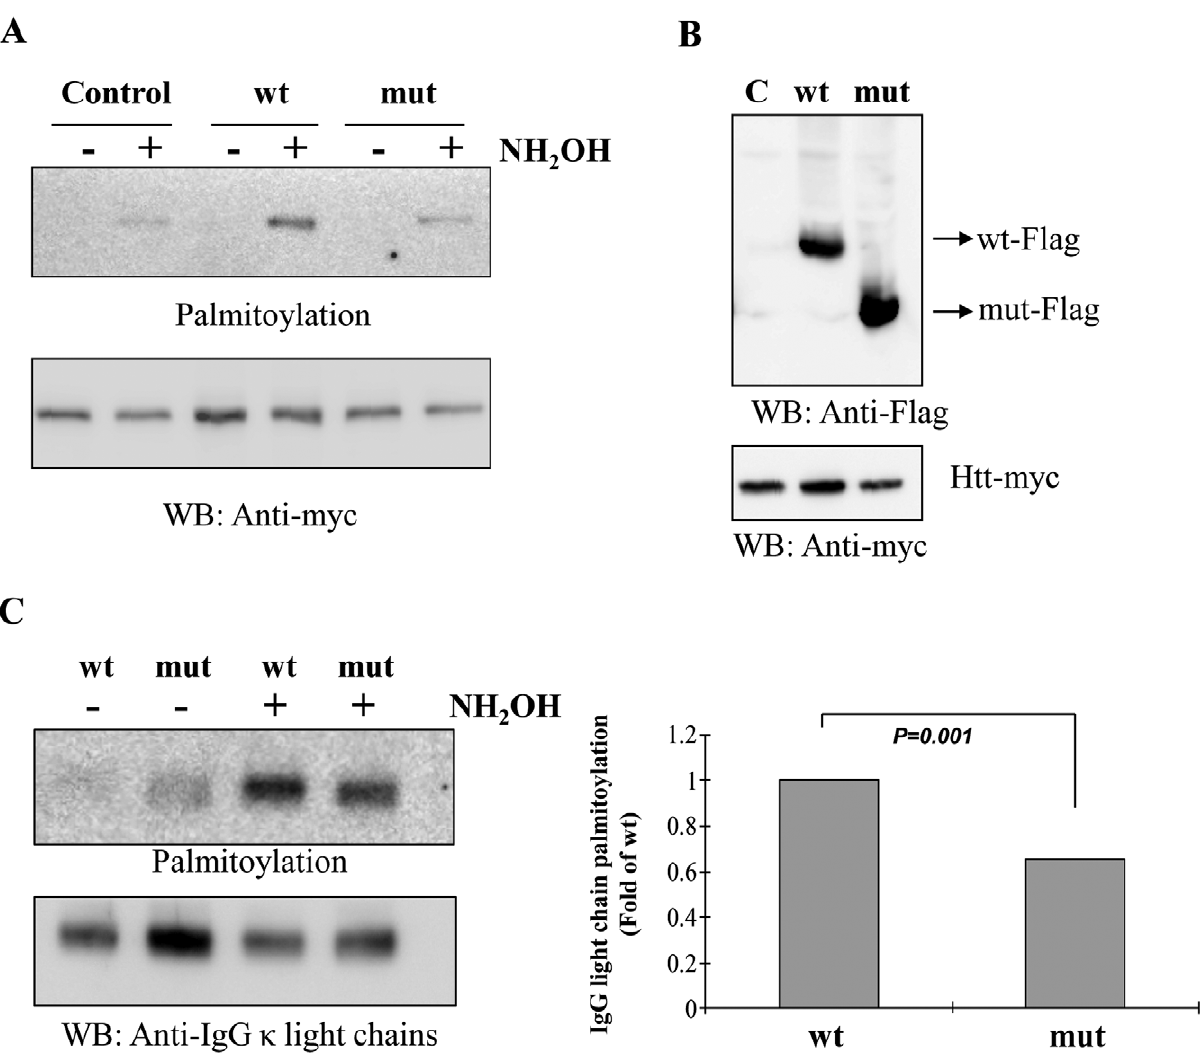
Figure 10. Palmitoyl-acyl transferase (PAT) activity and IgG light chain palmitoylation in the wild-type and mutant mice. (A) Acyl- biotin exchange assay showing palmitoylation of huntingtin (Htt) was greatly reduced by the mutant Zdhhc13 as compared to the wild type in the hydroxylamine (NH 2 OH)-treated group. Low panel was a loading control for huntingtin. Wt: wild Zdhhc13 , Mut: mutant Zdhhc13 , C: Control: cells transfected with huntingtin alone without co-transfection with Zdhhc13. WB: western blot, (B) HEK 293T cells co-transfected with huntingtin and Zdhhc13 showing expression of these proteins was approximately even, (C) Levels of IgG light chain palmitoylation in the wild-type and mutant mice. IgG light chain purified from serum of the wild and mutant mice were labeled with S-palmitoylation using acyl-biotin exchange method. IgG light chain treated with hydroxylamine showed reduced palmitoylated signals in mutant mice as compared to the wild type (p=0.001, n=3, t test). Low panel was a loading